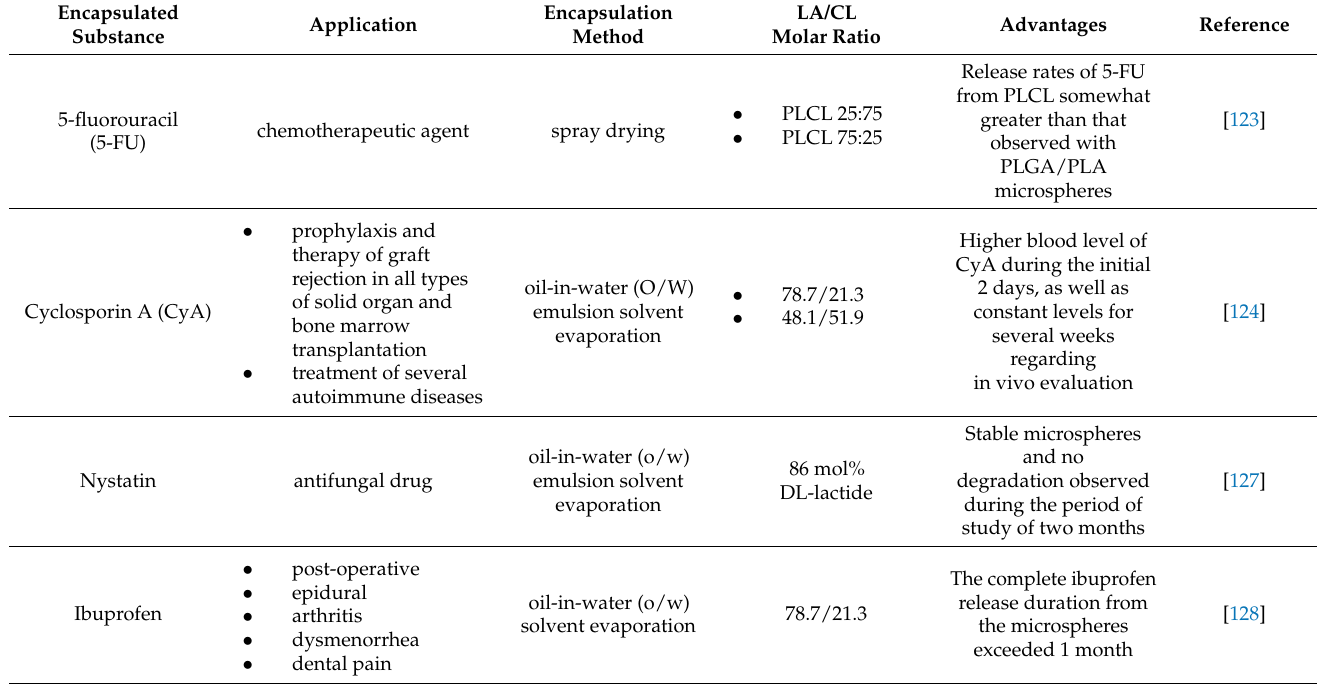
Table 5. PLCL microencapsulated formulations for various